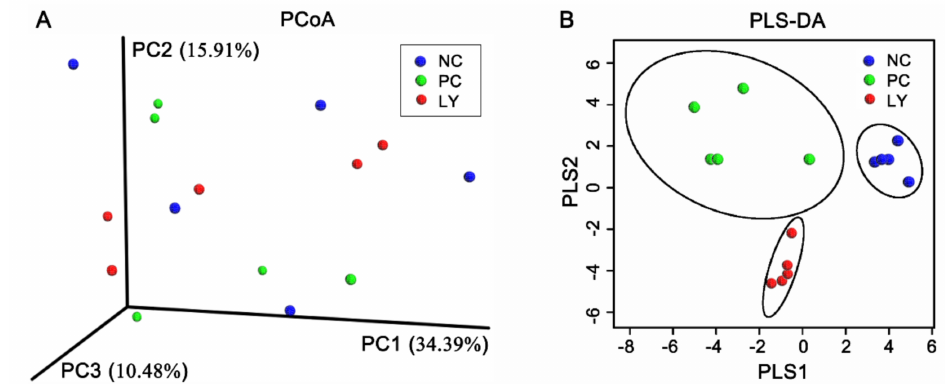
Figure 2. Microbial β -diversity in the cecum of broilers. ( A ) Principal coordinate analysis (PCoA) of weighted distance calculated from operational taxonomic unit (OTU) abundance matrix. ( B ) Partial least squares discriminant analysis (PLS-DA). NC—negative control, basal diets; PC—positive control, basal diets supplemented with antimicrobials; LY—basal diets supplemented with compound probiotics.